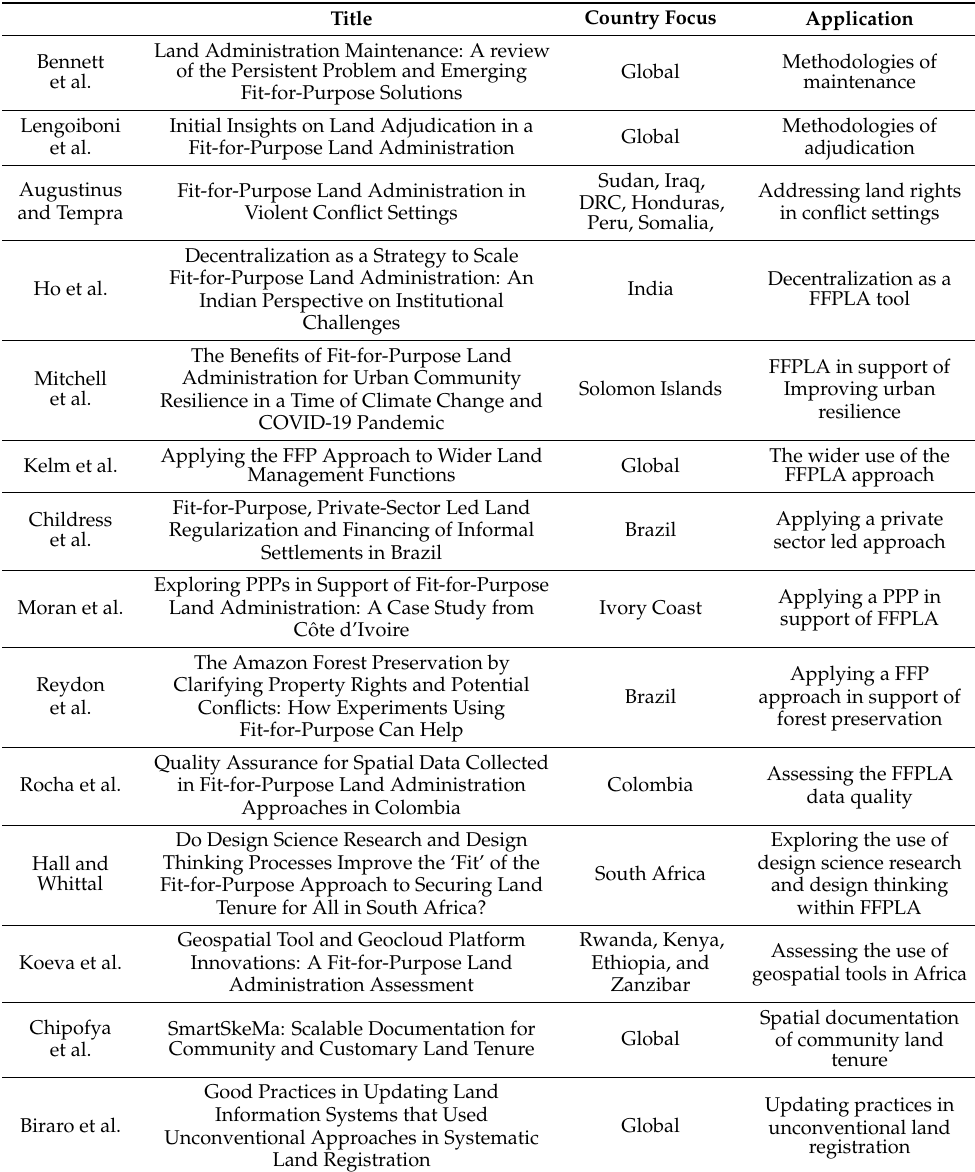
Table 1. Conceptual